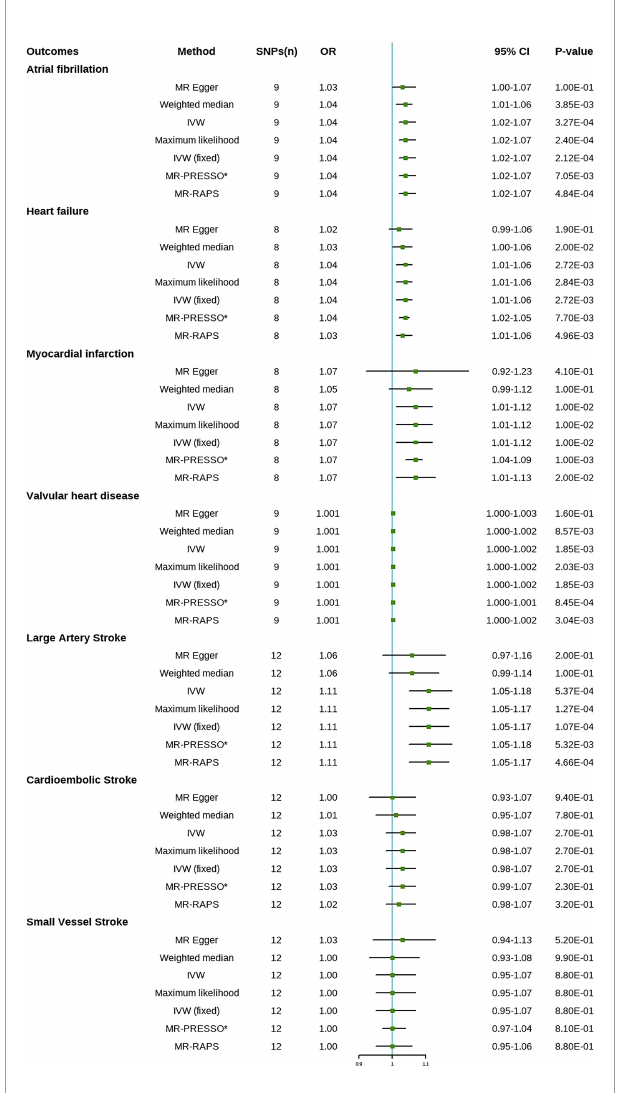
FIGURE 1 | Mendelian randomization estimates of psoriasis on the risk for cardiovascular disease (CVD). SNPs, single-nucleotide polymorphisms; OR, odds ratio; CI, con fi dence interval; IVW, inverse variance-weighted; IVW ( fi xed), fi xed-effects inverse variance-weighted; MR-RAPS, MR-robust adjusted pro fi le score; MR-PRESSO, MR-pleiotropy residual sum and outlier. *No outlier was